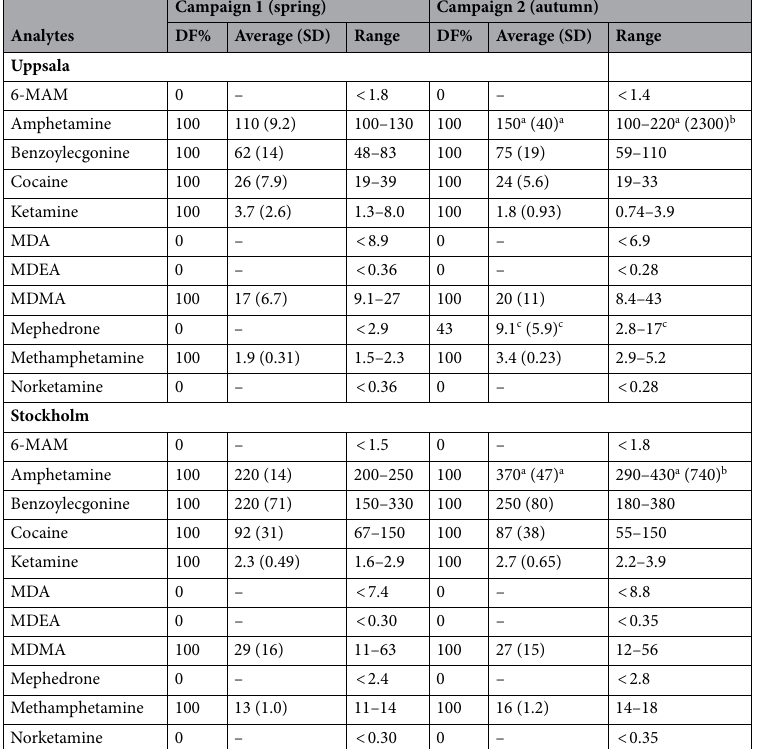
Table 2. Detection frequency (DF%) and daily mass loads (mg/day/1000 people) of drug residues in the influent wastewater from Uppsala and Stockholm WWTP in two different monitoring weeks. –, not calculated due to DF 0%; SD, standard deviation. a Excluded the outlier (see “Methods” for details). b The outlier value on Monday. c Quantifiable in samples only from Wednesday to